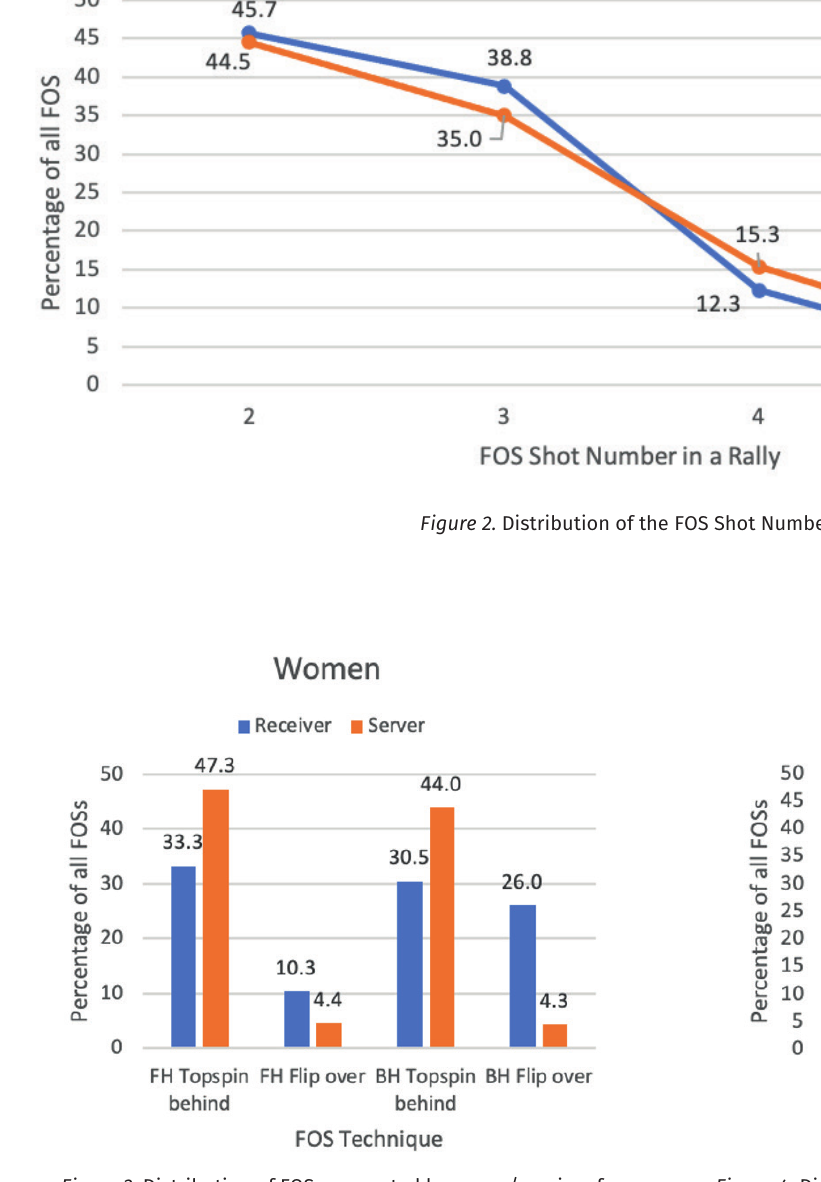
Figure 4. Distribution of FOSs separated by server/receiver for